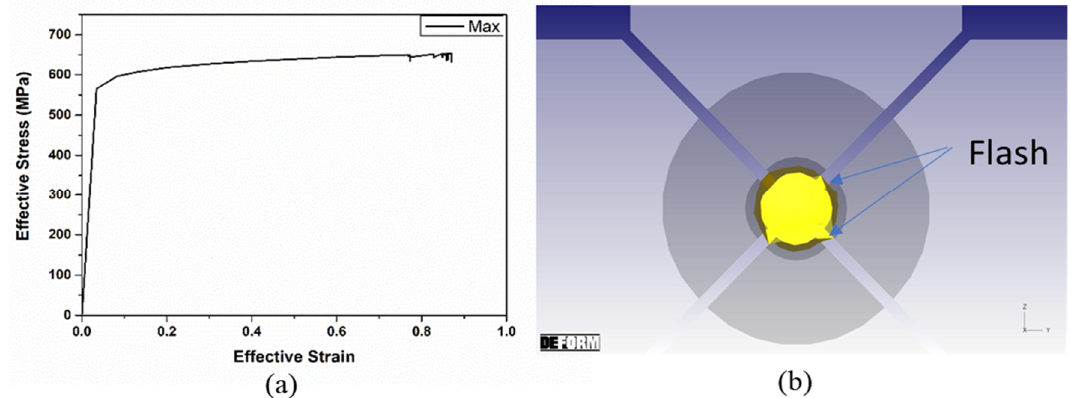
Figure 3. ( a ) The true σ versus the true ε of the work piece, obtained from numerical data, and ( b ) the flash produced over the outer surface of the work piece